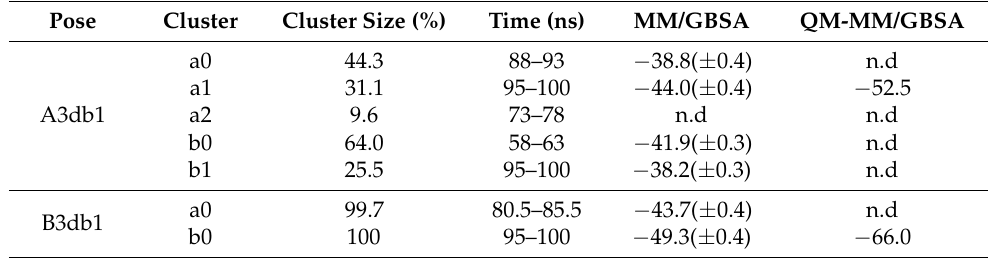
Table 2. Refinement of MDs results of TPA14 in r FAAH: cluster analysis and free-energy estimation. Data are reported for best clusters in the monomer A (a) and B (b). Time represents the time interval (in ns) used for MM/GBSA and QM/MM free-energy calculations. Free energies are in kcal/mol. n.d. = no